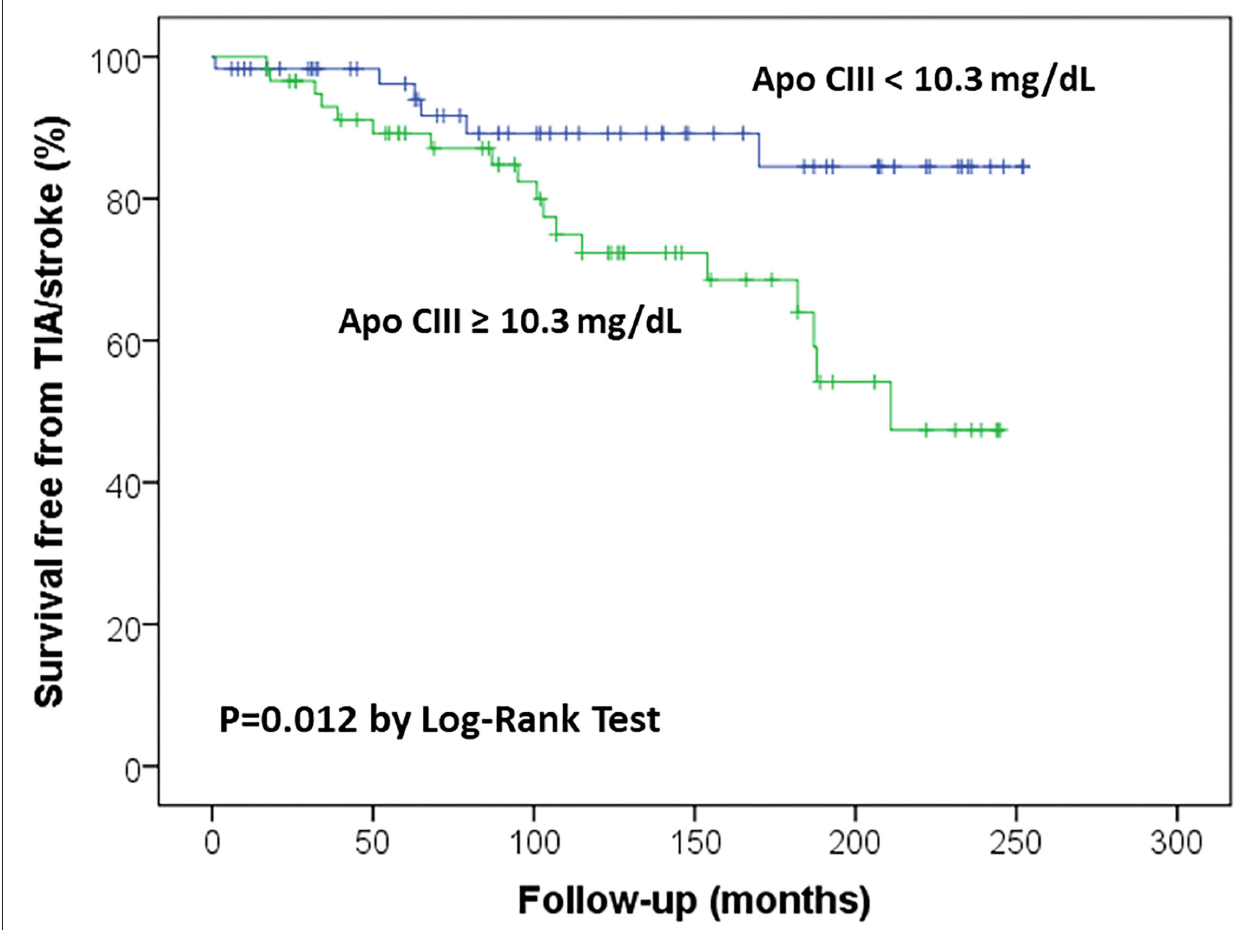
FIGURE 1 | Kaplan-Meier survival curves for ischemic stroke/transient ischemic attack (TIA) in the study sample according to Apolipoprotein C-III (Apo CIII) plasma concentration, with the median level (10.3 mg/dL) as threshold